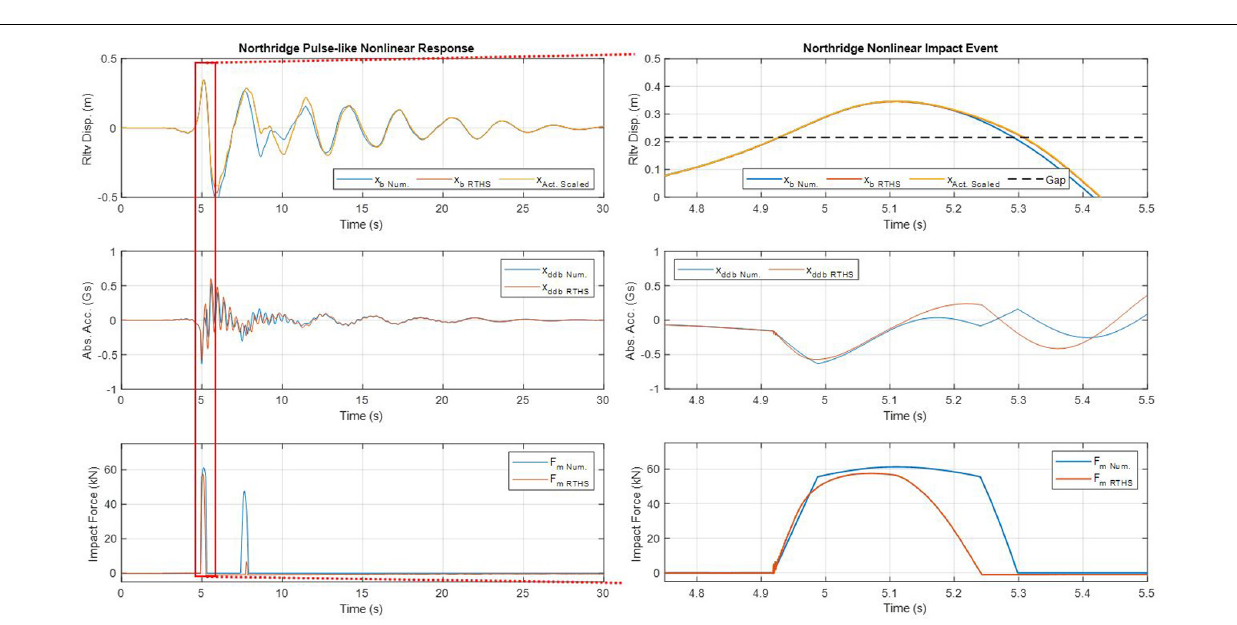
FIGURE 10 | Time history of the response to the Northridge Pulse-like ground motion for the nonlinear impact